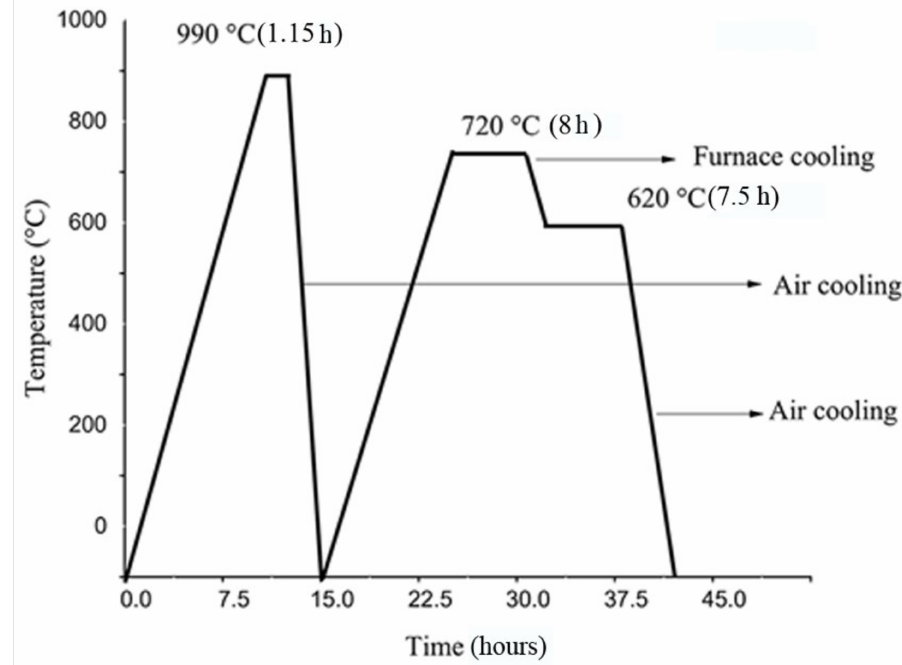
Figure 1. Typical solution treatment and two-step aging cycle.